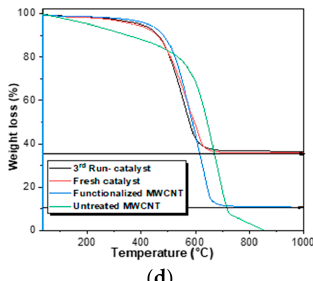
Figure 1. TEM micrographs of ( a ) functionalized multi-walled carbon nanotubes (MWCNTs), ( b ) magnetite/multi-walled carbon nanotubes (Fe 3 O 4 /MWCNTs), and ( c ) Fe 3 O 4 /MWCNTs-2 (second reuse); ( d ) TGA of the untreated support, functionalized support, the fresh catalyst, and third reuse.